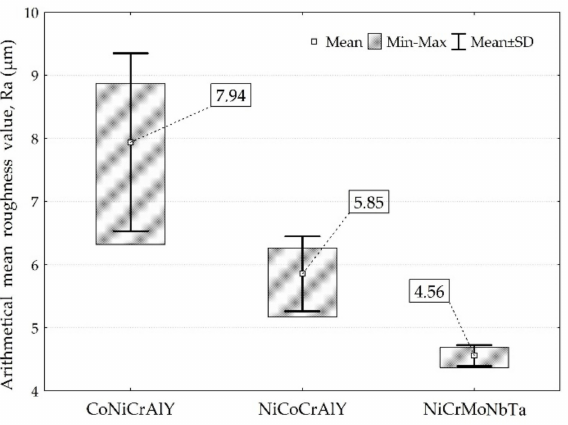
Figure 4. Comparison of the roughness of as-sprayed